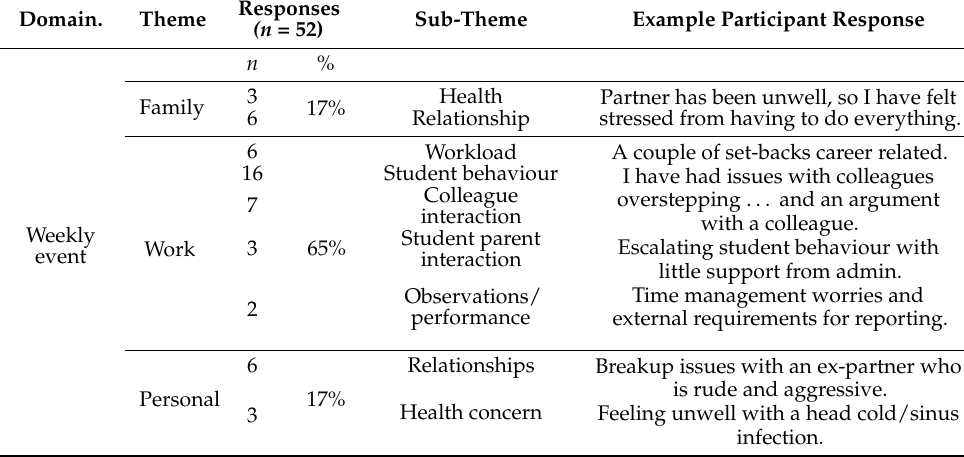
Table 4. Participant weekly reflection negative events.